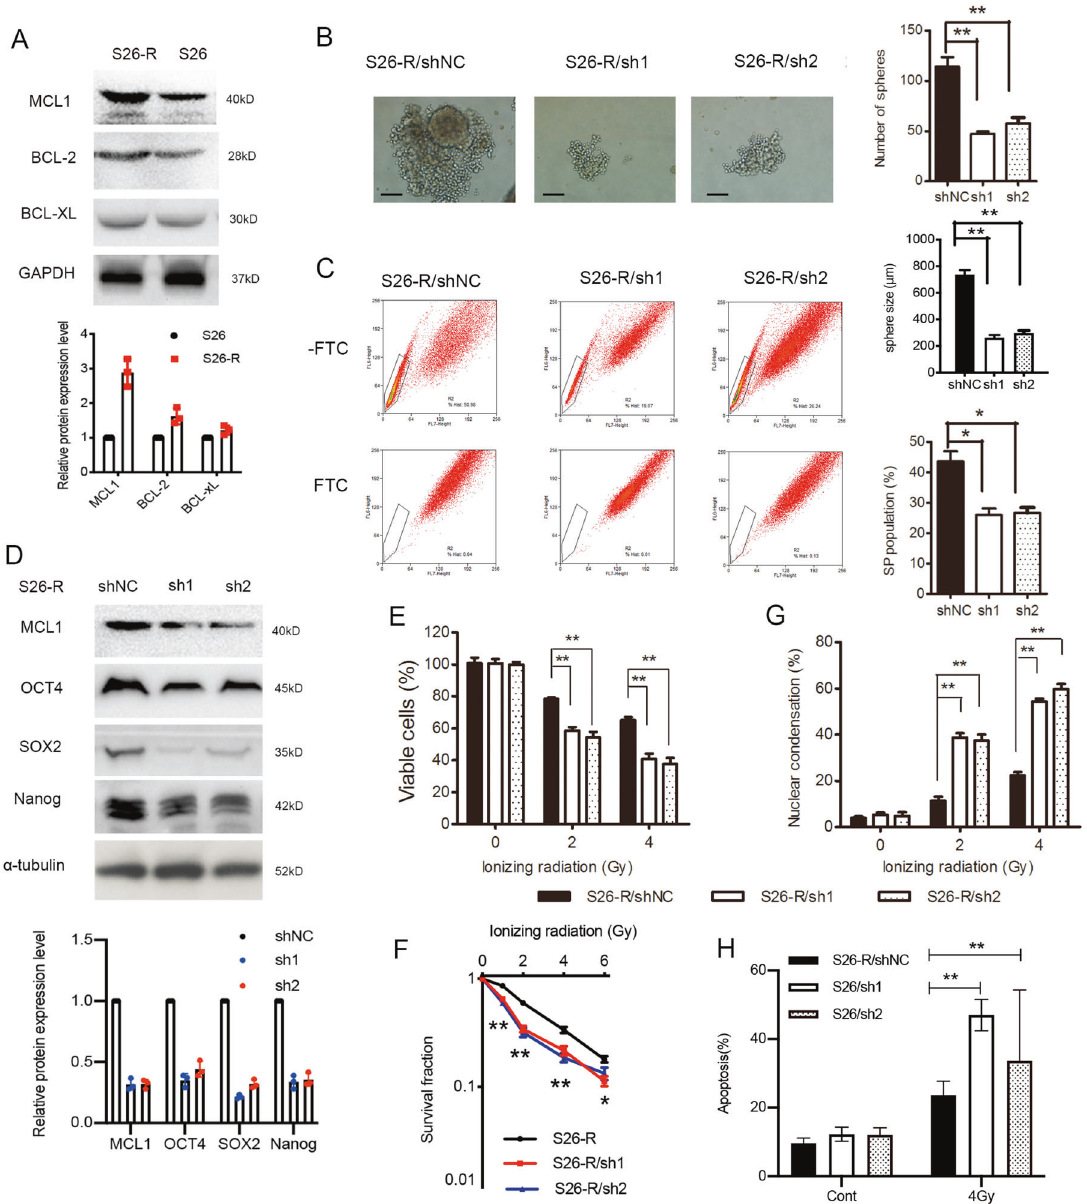
Fig. 3 MCL-1 depletion in radioresistant NPC cells inhibited stem-cell characteristic and restored radiation sensitivity. S26 NPC cells were irradiated by daily exposure (5 days per week, for 6 weeks) to single fractions of 2 Gy X-ray radiation to acquire radioresistant cell line S26-R. A Western blotting analysis of BCL-2 family members expression in S26 and its radio-resistant S26-R cells. B – F S26-R cells stably transfected with shRNA targeting MCL1 (sh1, sh2) or scrambled shRNA (shNC) were analyzed as follows. ( B , left panel) Representative images of single-cell suspensions in ultra-low-attachment culture plates are shown. (Right panel) The formed spheroids were counted via microscopy (upper) and the size of spheroids were compared (lower), ** p < 0.01, Student ’ s t -test, Scale bar: 200 μ m. C Percentages of SP cells are shown in the left panel, and the right panels compare the SP formed in S26-R cells transfected with the shRNA targeting MCL-1 or its control, n = 3; * p < 0.05, Student ’ s t -test. D Protein levels of stem-cell markers were determined by western blotting, tubulin was used as the loading control. E Cell viability of S26-R cells transfected with shRNA targeting MCL-1 or its control after treatment with ionizing radiation determined by the MTS assay, ** p < 0.01, Student ’ s t -test. F Cell survival curve for treatment with increased doses of ionizing radiation in S26-R cells transfected with shRNA targeting MCL-1 or its control, * p < 0.05, ** p < 0.01, Student ’ s t -test. G , H S26-R cells transfected with shRNA targeting MCL1 or its control were treated with indicated dose of radiation, then necrotic cells are revealed by propidium iodide staining ( G ) and apoptotic cells are revealed by fl ow cytometry analysis ( H ). Quali fi cation results are shown, ** p < 0.01, Student ’ s t -test. (NPC, nasopharyngeal carcinoma; MTS, 3- (4,5-dimethylthiazol-2-yl)-5-(3-carboxymethoxyphenyl)-2-(4-sulfophenyl)-2H-tetrazolium; shRNA, short hairpin RNA; SP, side population). SUNE1 cells. The effect of NAC was con fi rmed by reduced ROS (Fig. 5E, F). To con fi rm the impact of ROS-AKT on MCL1 synthesis, level and HIF-1 α expression (Fig. S8C, D). Interestingly, NAC we use another NPC cell line, SUNE1, to test MCL1 level under treatment bene fi ted MCL1 inhibition (Fig. S8C). inhibitor and NAC treatment. Again, we observed AKT inhibitor The above data suggested that the ROS-AKT axis forms a treatment lead to MCL1, HIF-1 α downregulation and ROS level positive feedback loop that regulates MCL-1 protein synthesis, (Fig. S8A, B). N-acetylcysteine was also applied to treat